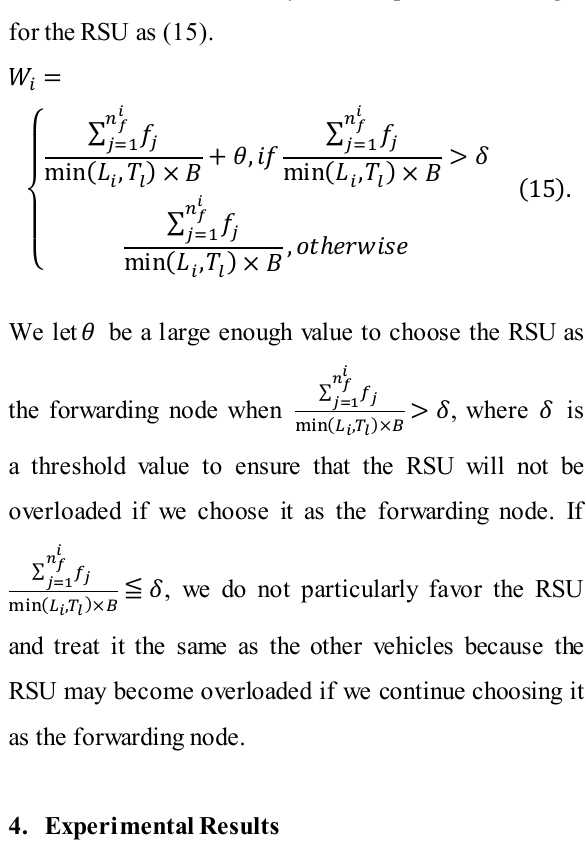
Fig. 5. The end-to-end delays of FAB, GPSR, and 3P3B with various vehicle